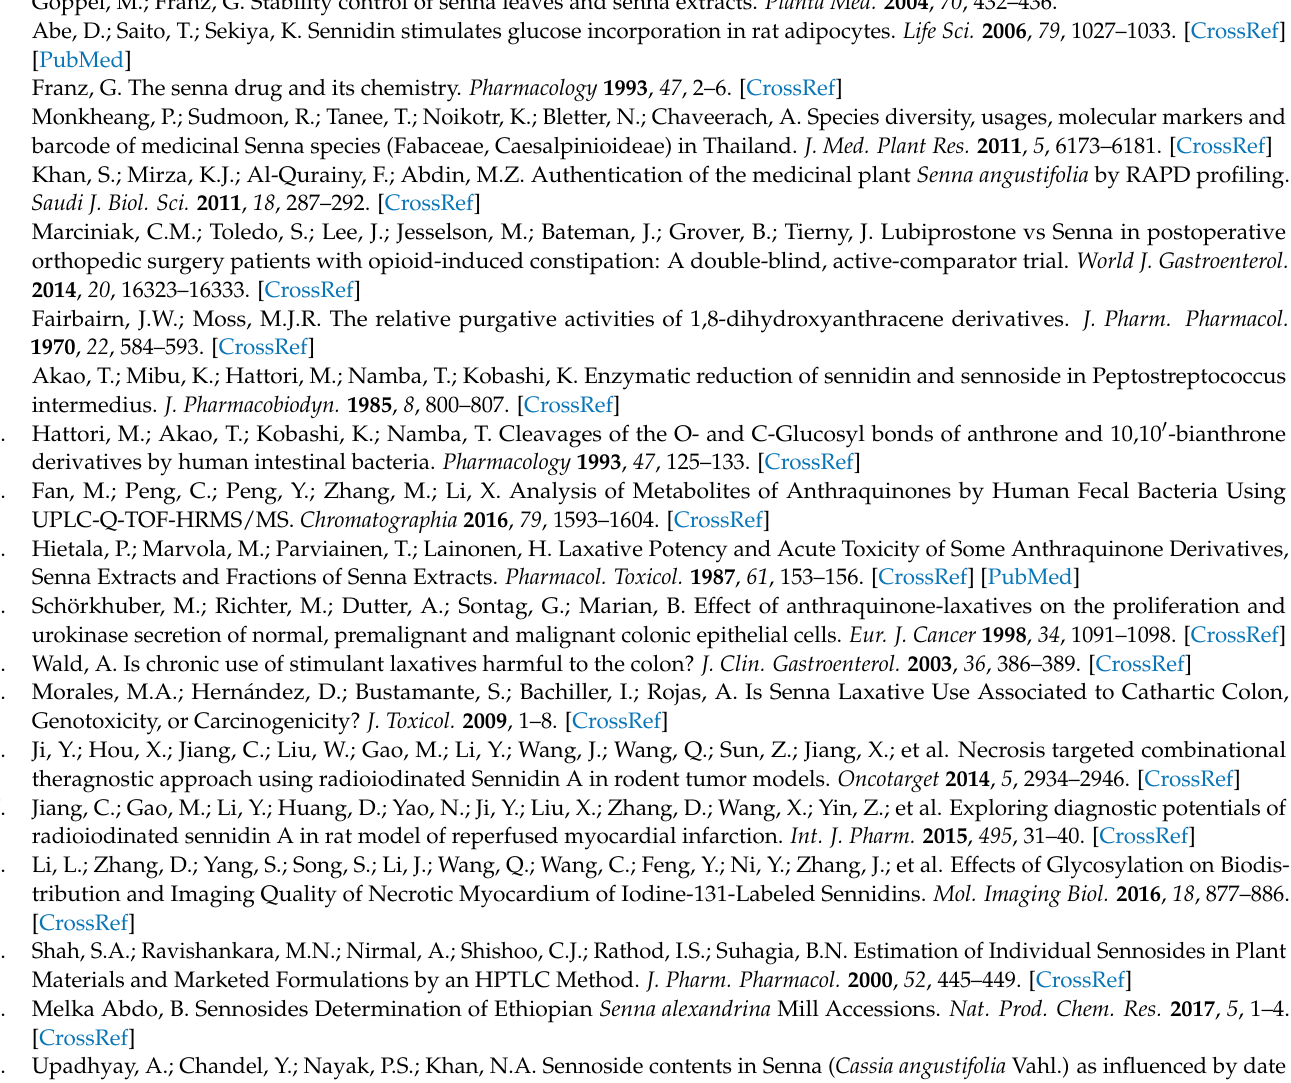
11—Red, Structure 17—Green, Figure S2. Theoretical IR Spectra for Sennidine B. Structure 7—Blue, 8—Black, 9—Red, 10—Green, Figure S3. Molecular Orbitals for Sennidine A—Structure 1, Figure S4. Molecular Orbitals for Sennidine B—Structure 7, Figure S5. Molecular Orbitals for Sennidine C—Structure 11, Figure S6. Molecular Orbitals for Sennidine D—Structure